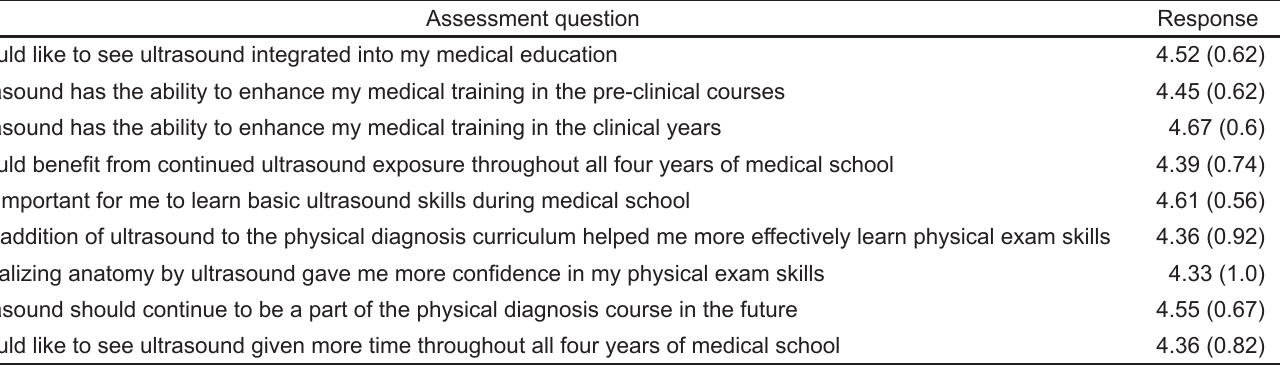
Figure. Assessment of students’ ability to identify basic structures in right upper quadrant. Liver marked with circle, kidney with stars, and diaphragm with Table 3. Average post-session PGY (postgraduate year)-2 student responses on scale from 1-5 (reported with standard deviation) given after physical exam course incorporating ultrasound.